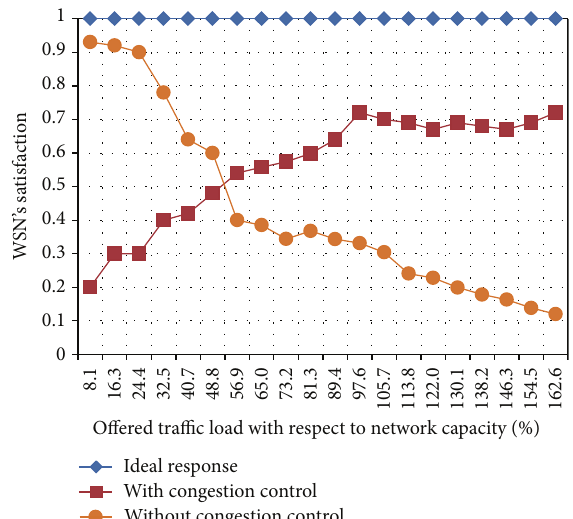
Figure 4: Lost packets versus buffer size for delay-tolerant applica- tions.